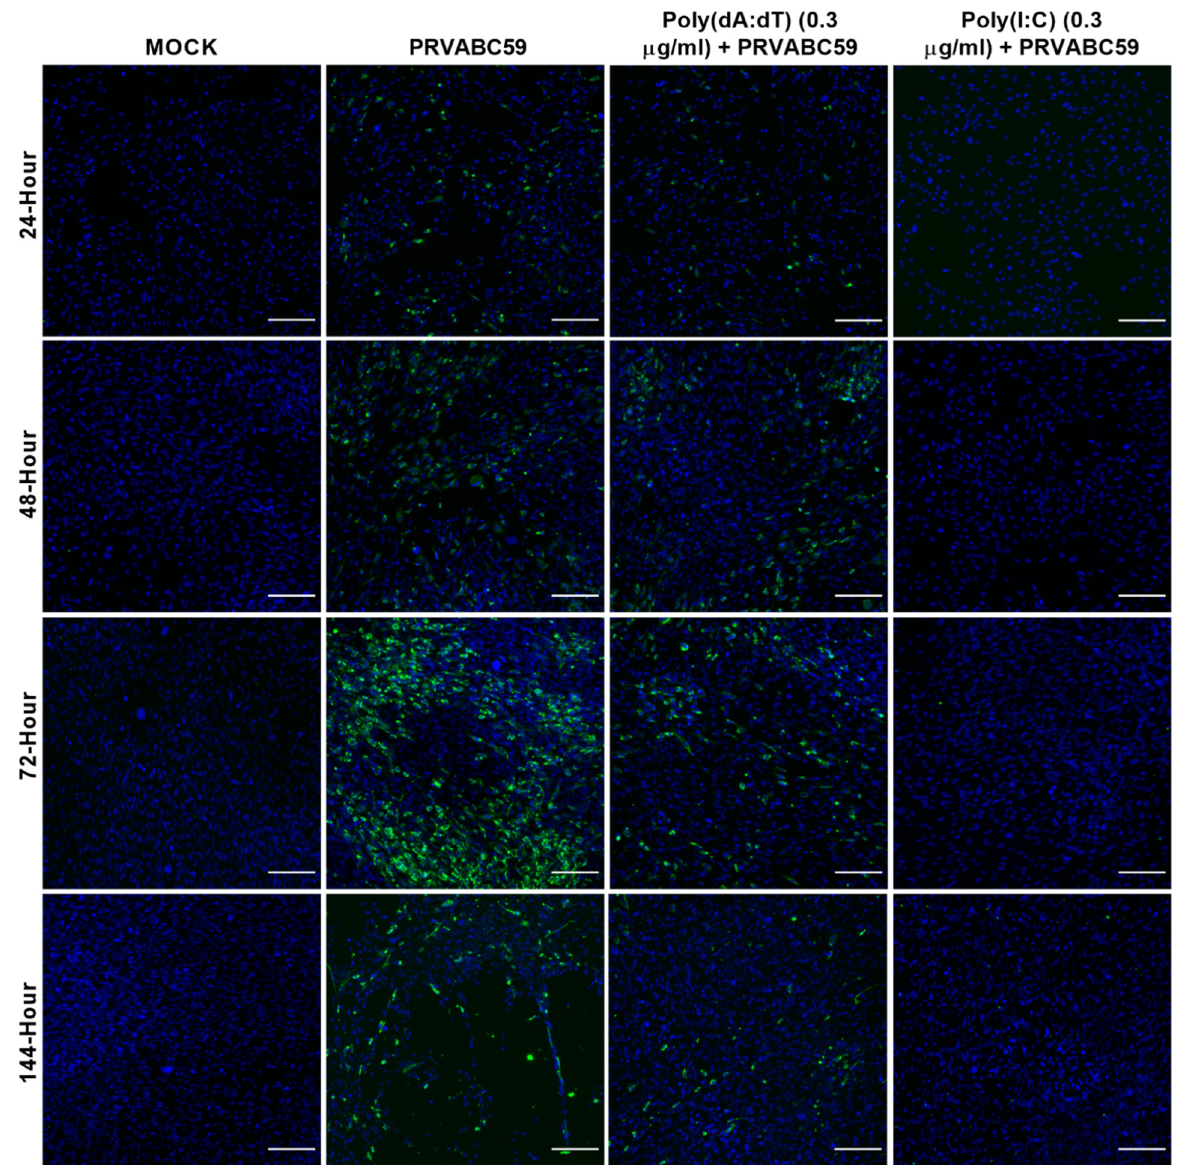
Figure 6. The 0.3 µg/mL poly(dA:dT) and poly(I:C) pre-stimulated HASTR/ci35 astrocyte cells are able to control Zika virus strain PRVABC59 infection. Subconfluent ZIKV-susceptible HASTR/ci35 astrocyte cells were transfected with low concentrations (0.3 µg/mL) of poly(I:C) and poly(dA:dT) 18 h prior to infection with PRVABC59 ZIKV strain at an MOI of 0.1. Poly(I:C) showed complete control of the virus at this very low concentration whereas poly(dA:dT) was relatively less effective at this concentration. Cells were fixed at 24-, 48-, 72- and 144-h timepoints and then stained with 4G2 antibody to detect ZIKV envelope protein Env (stained green) and DAPI stain for cell nuclei (stained blue). Scale bars represent 200 µ